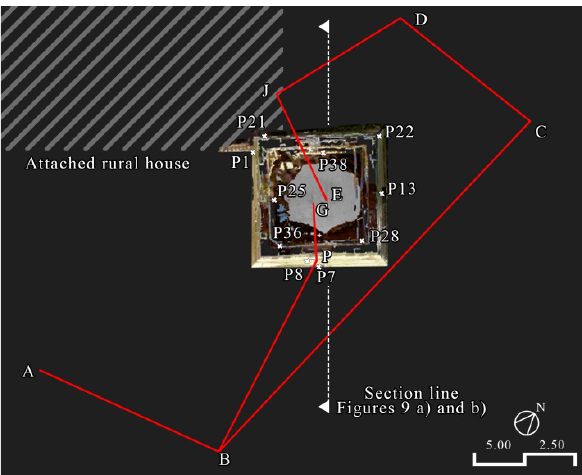
Table 1. Local coordinates of the station points used, linked through classic topography